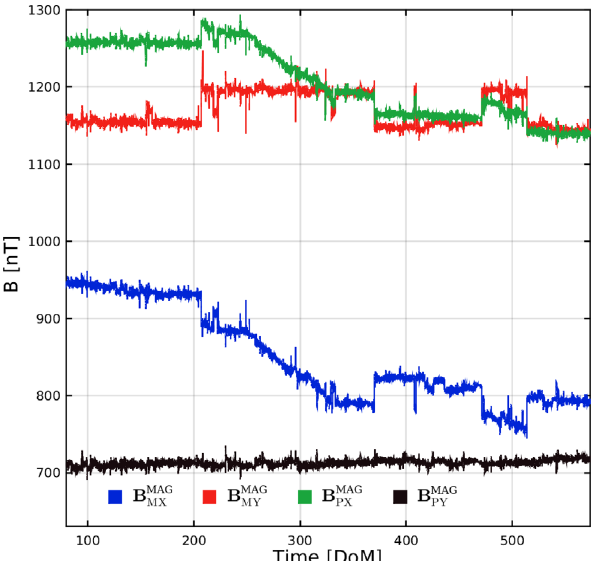
Figure 2. Magnetic fi eld intensities recorded by the four LPF 3-axis fl uxgate magnetometers during the time the S/C was orbiting around the Lagrange point L1 from February 16, 2016, through June 30, 2017. Datasets were sampled at 2 (cid:1) 10 (cid:3) 1 Hz and downsampled at 3 (cid:1) 10 (cid:3) 4 Hz. Time is indicated in days of mission (DoM) after the LPF launch (4:04 UTC, December 3,